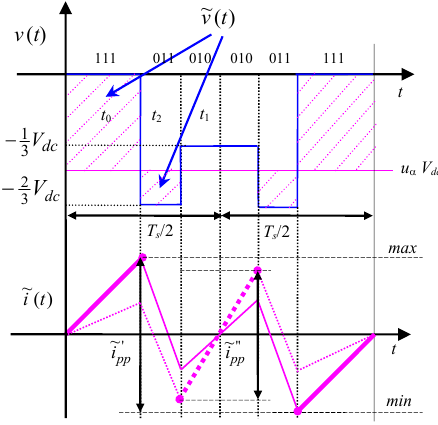
Figure 14. Output voltage and current ripple for DPWM+ technique in one switching period (sector III, − 1/ √ 3 ≤ u α ≤ − 1/3).